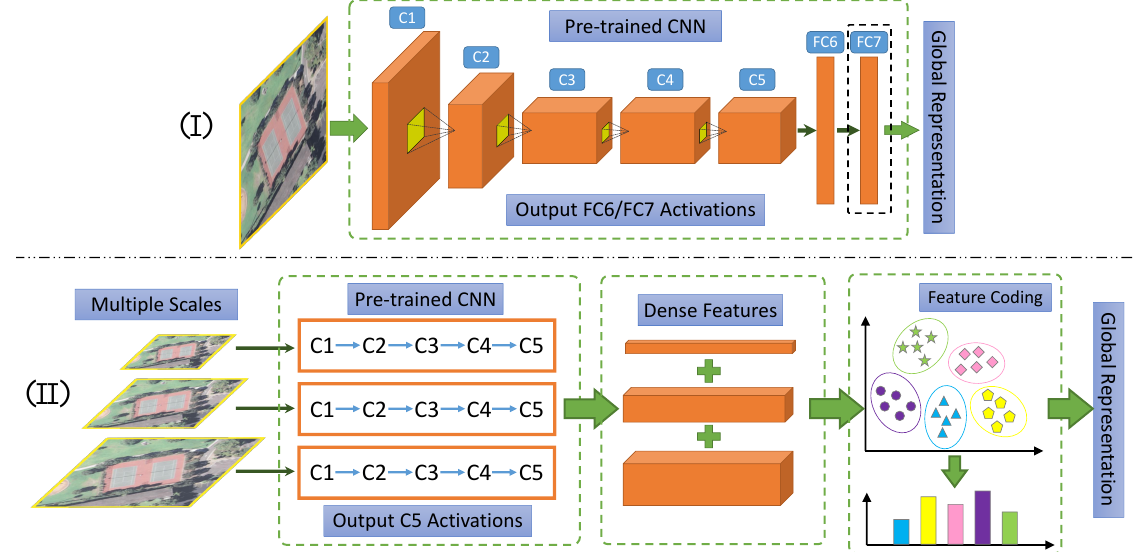
Figure 3. Illustration of the two proposed scenarios for generating global